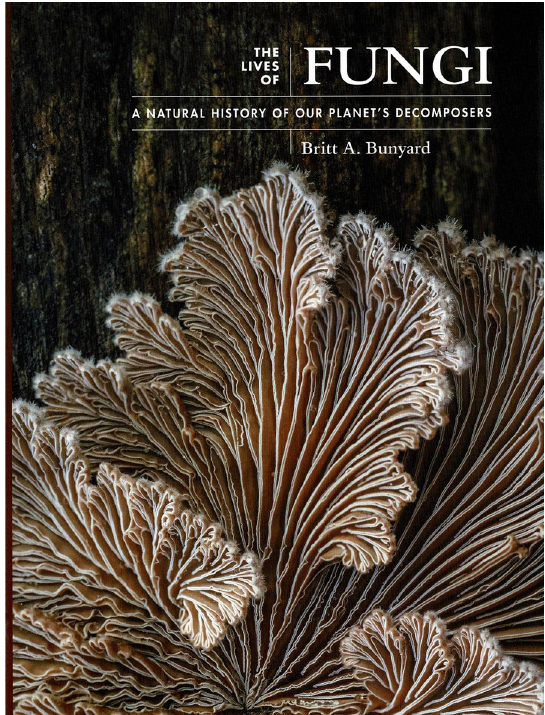
Fig. 21 The lives of fungi